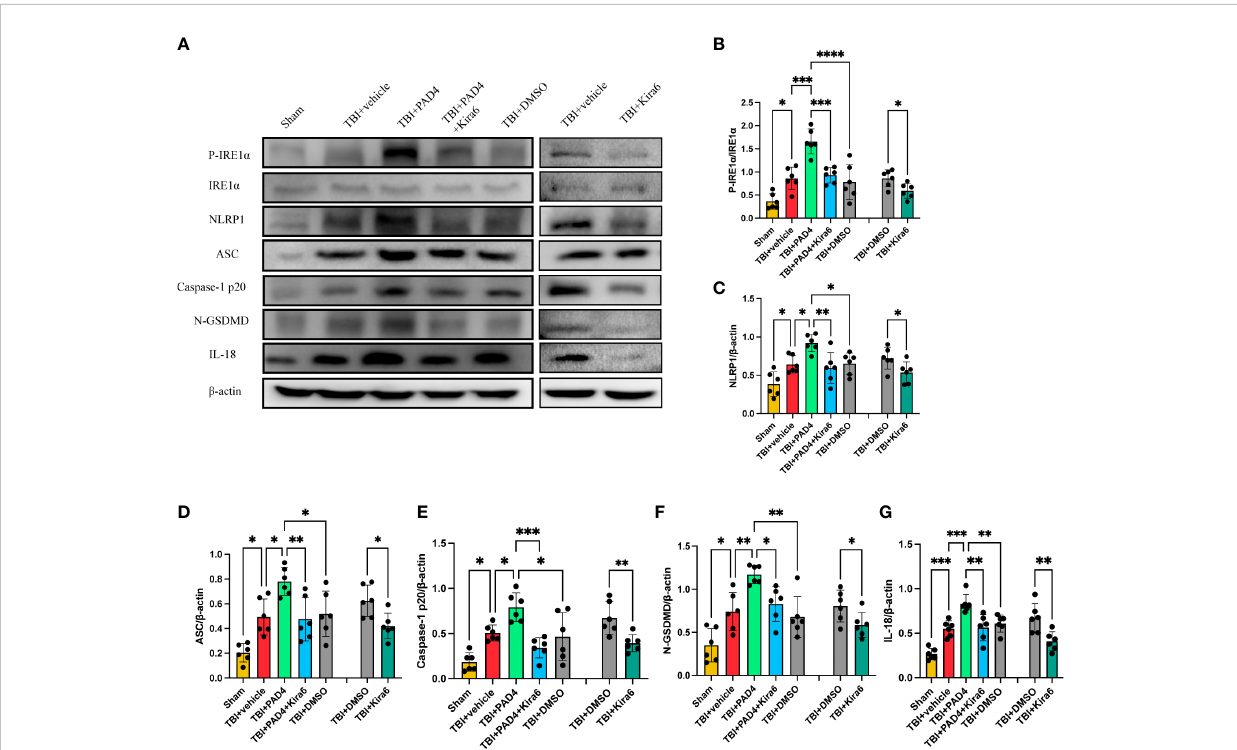
FIGURE 7 Inhibition of IRE1 a ameliorates neurons ’ pyroptosis by inhibiting the STING-IRE1 a -NLRP1 pathway. (A) Representative Western blot bands of P-IRE1a (B) , NLRP1 (C) , ASC (D) , Caspase-1 p20 (E) , NGSDMD (F) and IL-18 (G) . and statistical analysis expression level of STING (B) , P-IRE1 a (B) , NLRP1 (C) , ASC (D) , Caspase-1 p20 (E) , N-GSDMD (F) and IL-18 (G) in brain tissue of mice post-TBI 3 days (n=6). Data are presented as mean ± SD. *P < 0.05, **P < 0.01, ***P < 0.001 and ****P < 0.0001 compared within two